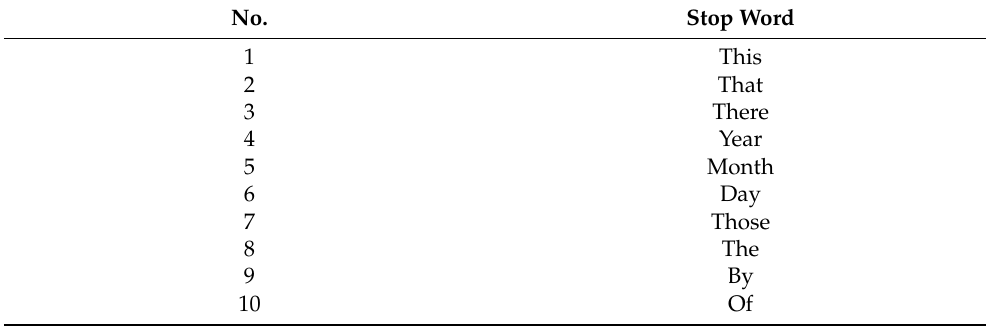
Table 2. Stop word